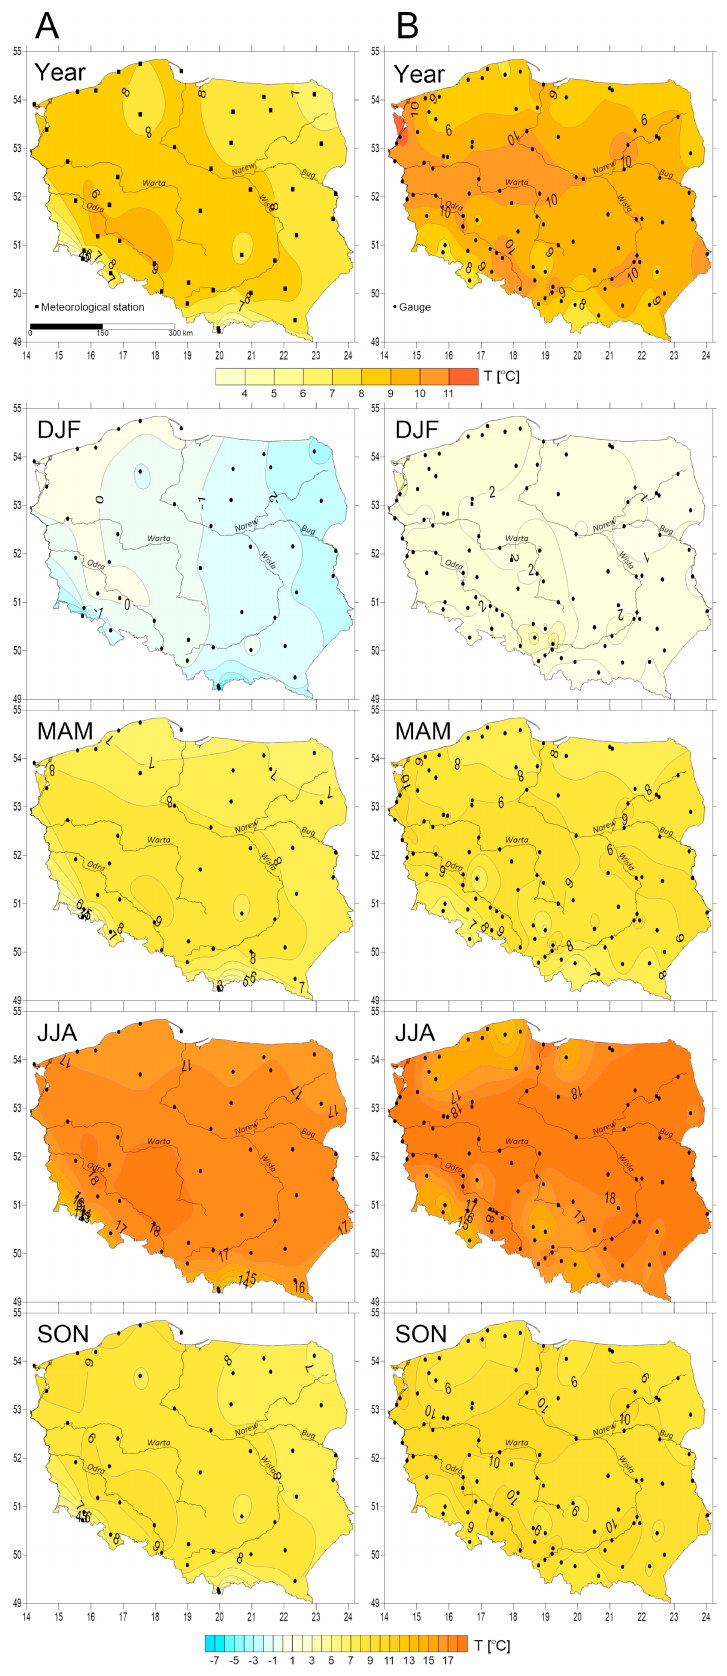
Figure 2. Spatial distribution of average annual and seasonal air ( A ) and river water ( B ) temperature values.